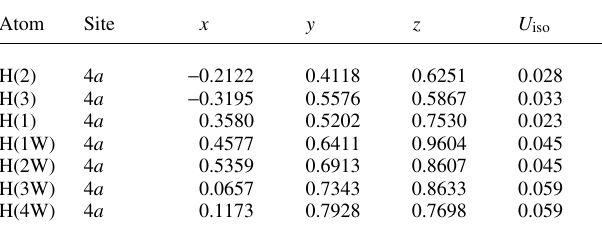
Table 2. Atomic coordinates and displacement parameters (in Å 2 )